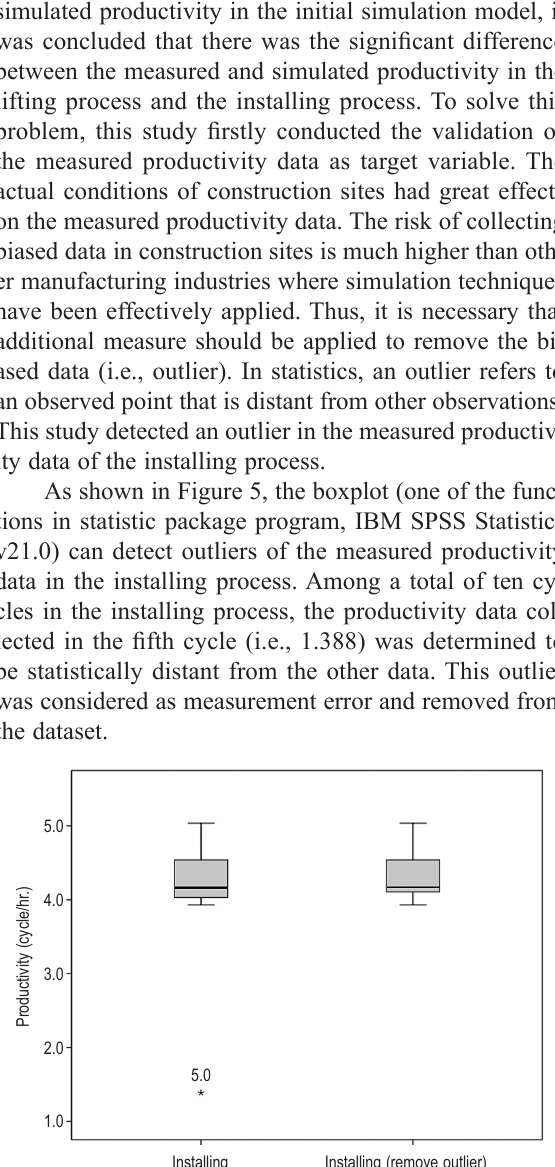
Installing (remove outlier)Installing